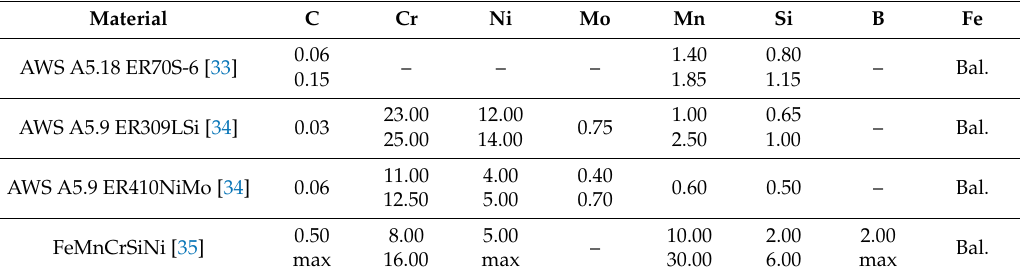
Table 2. Predicted Thermally sprayed alloys chemical composition